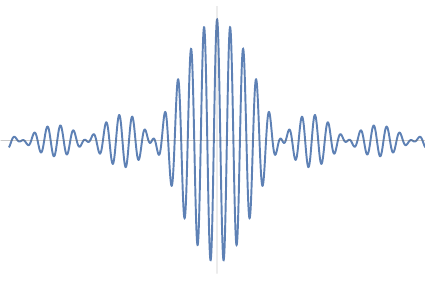
Figure 1. The wave packet (2.8) for the distribution eq.